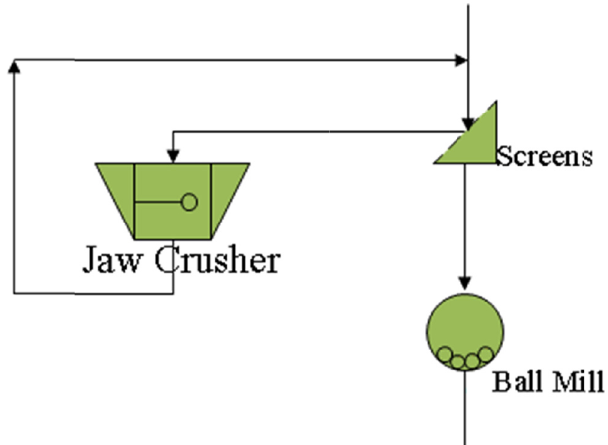
Fig. 1. Crushing and screening of